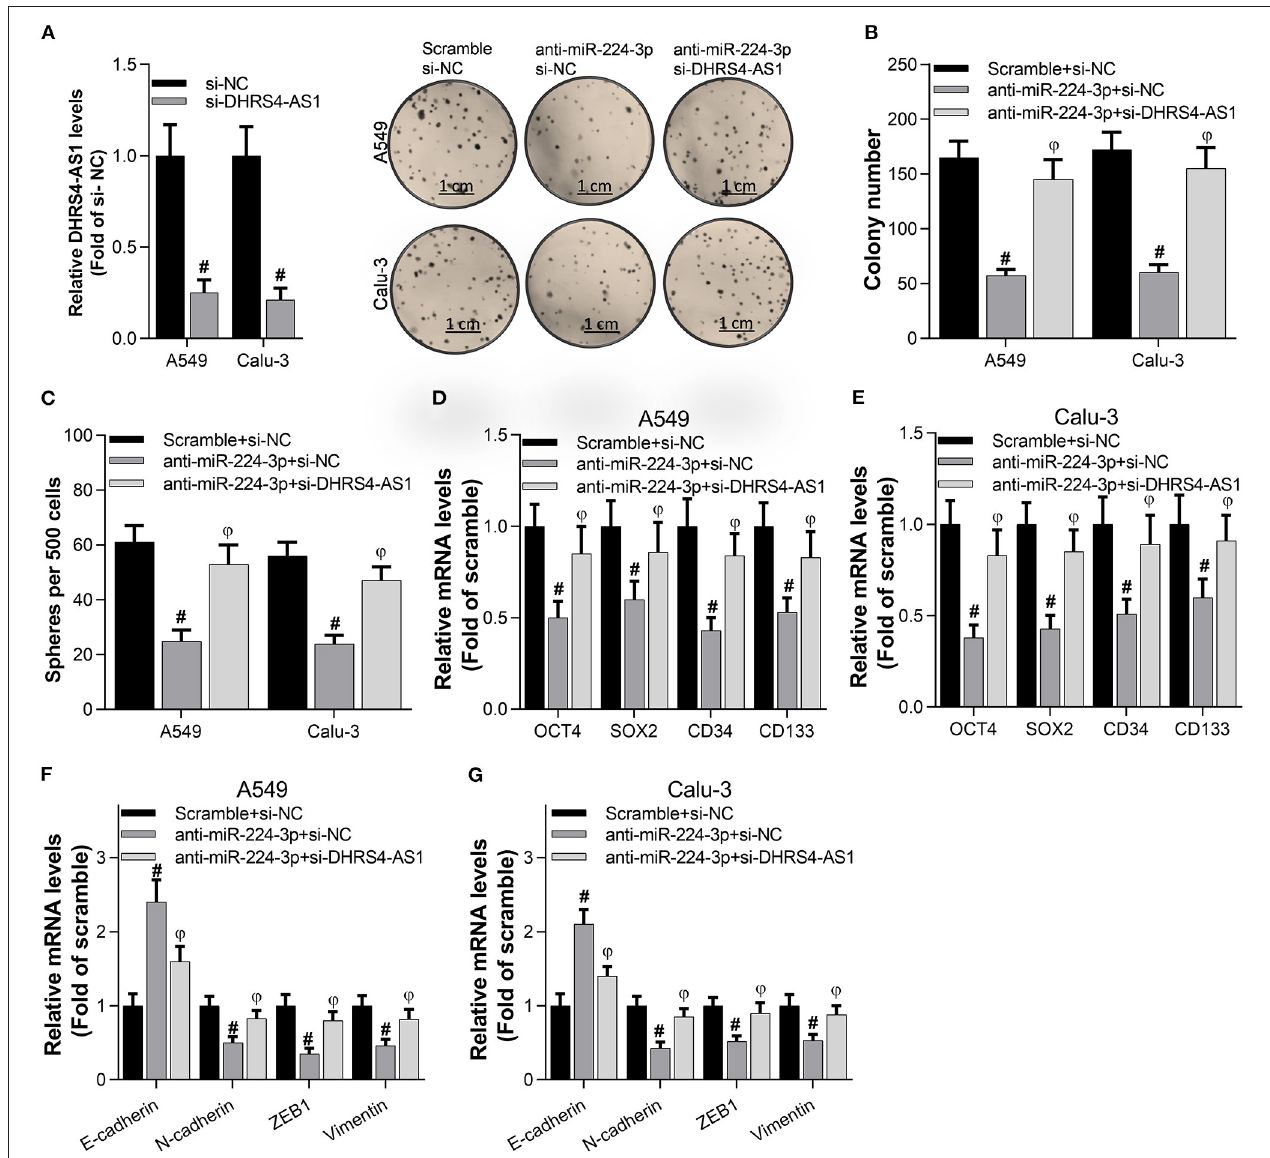
FIGURE 4 | DHRS4-AS1 knockdown reversed the anti-miR-224-3p-mediated inhibition of colony formation and stem cell-like properties in vitro . (A,B) Colony formation analysis of cancer stem cell proliferation after 20 days of transfection, at which point the colonies were captured and counted; # p < 0.01 vs. scramble + si-NC, ϕ p < 0.01 vs. anti-miR-224-3p + si-NC. And the DHRS4-AS1 levels were determined by using real-time PCR after 48h transfection. (C) Quantification of cancer stem cell spheres after 72h of transfection; # p < 0.01 vs. scramble + si-NC, ϕ p < 0.01 vs. anti-miR-224-3p + si-NC. (D,E) Real-time PCR analysis of the expression of cancer stemness-related genes after 72h of transfection; # p < 0.01 vs. scramble + si-NC, ϕ p < 0.01 vs. anti-miR-224-3p + si-NC. (F,G) Real-time PCR analysis of the expression of EMT-related factors in tumor spheres; # p < 0.01 vs. scramble + si-NC, ϕ p < 0.01 vs. anti-miR-224-3p + si-NC. All the results are expressed as the mean ± SD from three independent experiments, and each sample was repeated in